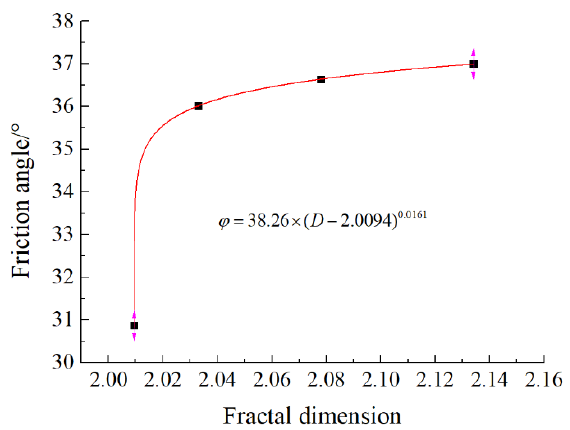
Figure 15. Curves of fractal dimension and interface friction angle.